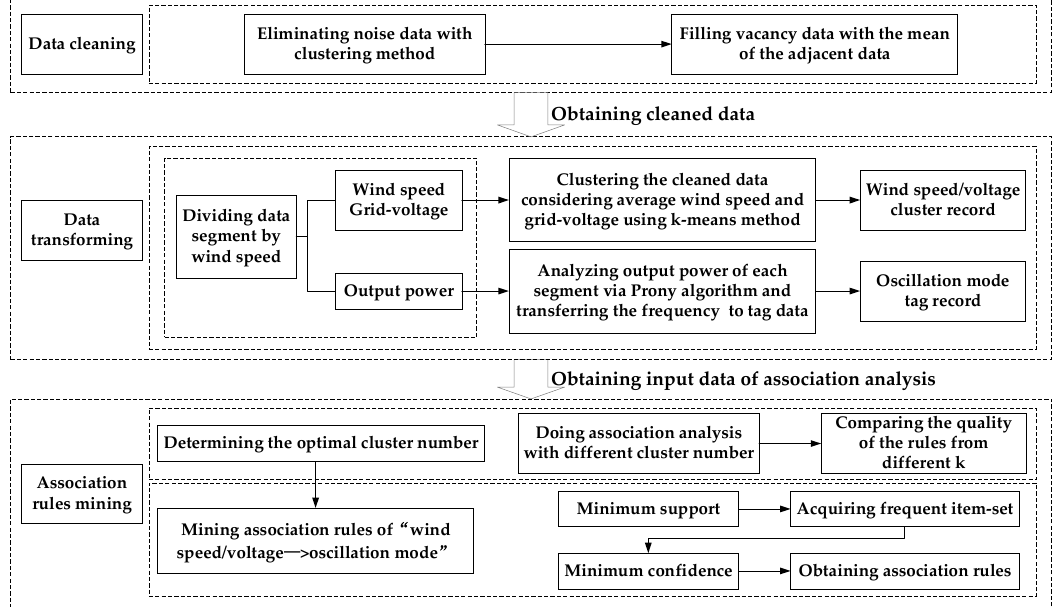
Figure 5. Correlation Analysis Modeling Process.